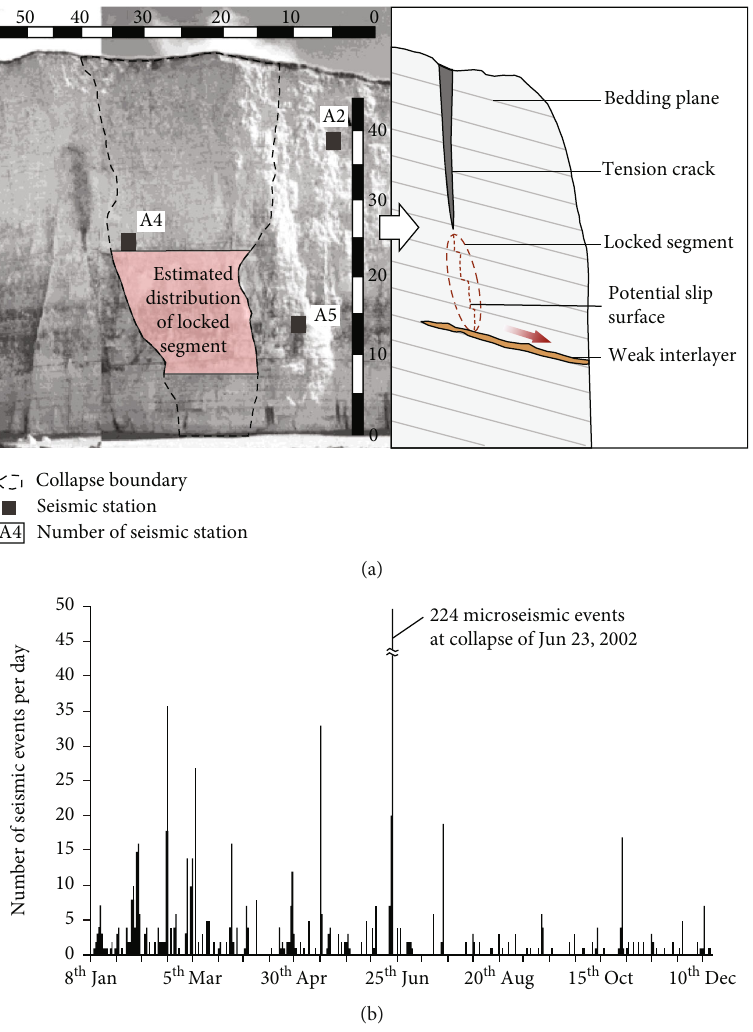
Figure 2: A rockcli ff pro fi le and its microseismic monitoring record at Mesnil-Val, Normandie, NW France (modi fi ed from Senfaute et al. [12]): (a) trailing-edge slip surface after collapse and diagram of inferred pro fi le before the collapse; (b) microseismic time-series recorded by A4 seismic